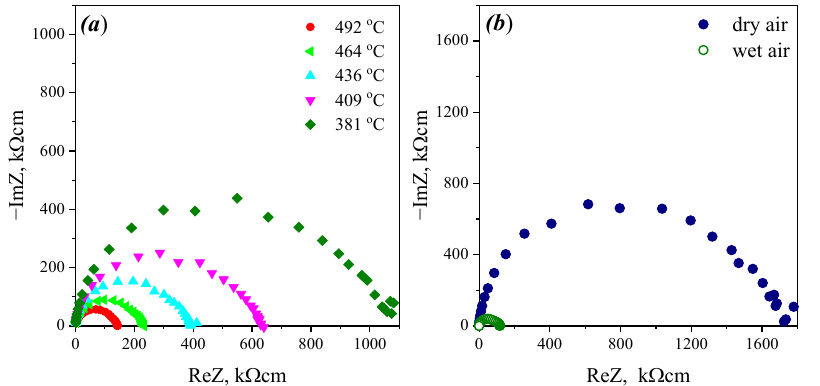
Figure 7. Impedance spectra for Ba 5 In 2 Al 2 ZrO 13 at different temperatures in dry air ( a ), and the com- parison in dry ( p H 2 О = 3.5·10 −5 atm) and wet air ( p H 2 О = 1.92·10 −2 atm) at 350 °C ( b ).